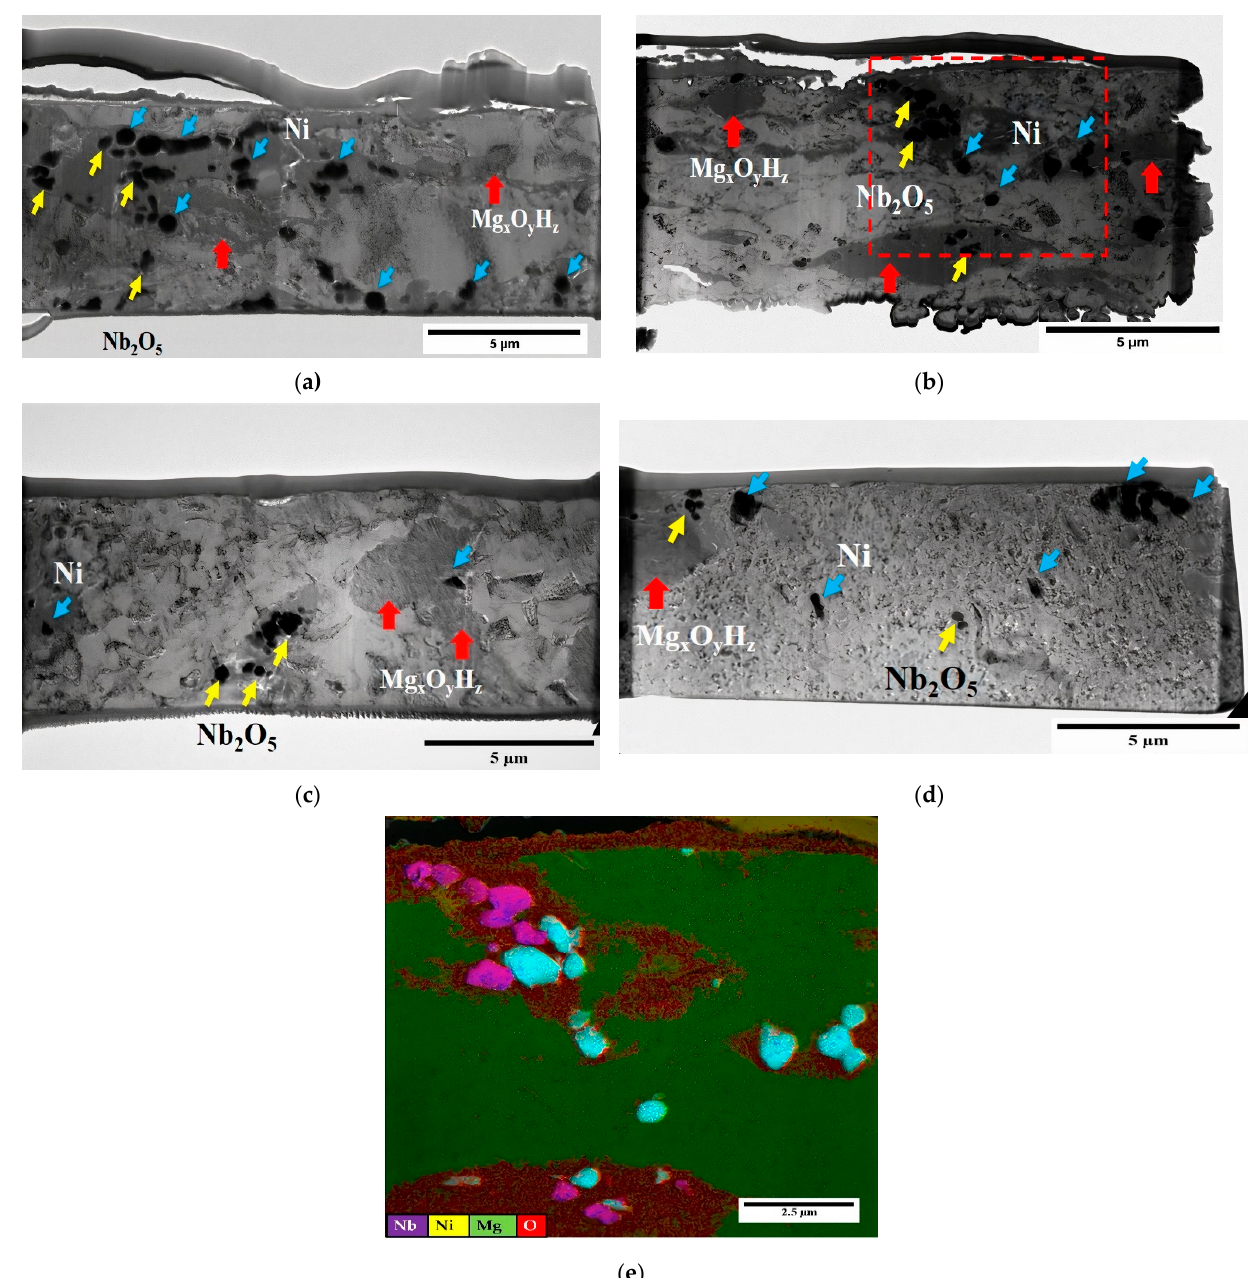
Figure 5. TEM micrographs of thin lamellae from samples subjected to 5 N ( a , b ) and 20 N ( c , d ) under 5 GPa of pressure at locations near the center ( a , c ), periphery ( b , d ) of the disks and ( e ) Superimposed EDS X-ray elemental maps of region marked in sample ( b ). Arrows indicate Ni particles (blue), Nb 2 O 5 particles (yellow), and Mg x O y H z (red) and the light gray matrix corresponds to Mg grains.